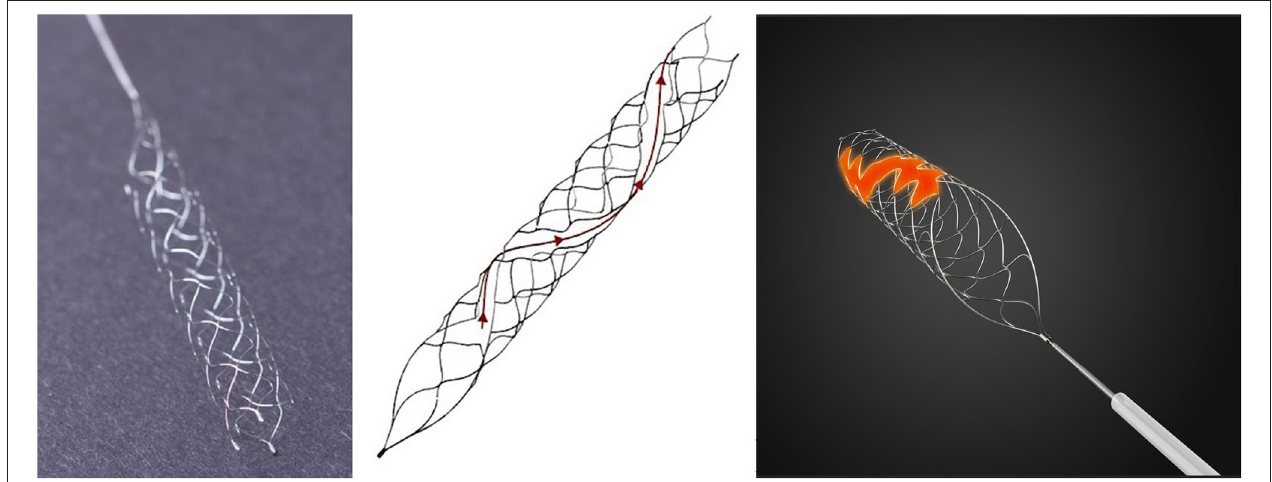
FIGURE 1 | The Tonbridge device and the unique design of the longitudinal spiral opening along its tubular